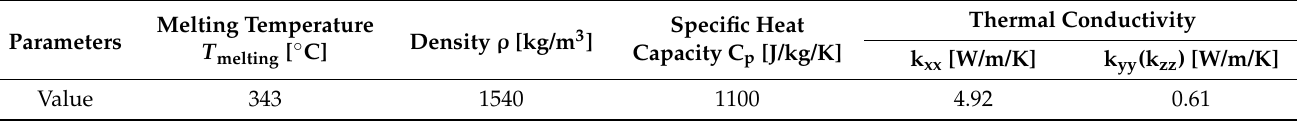
Table 1. Material constants of the CF/PEEK composite.